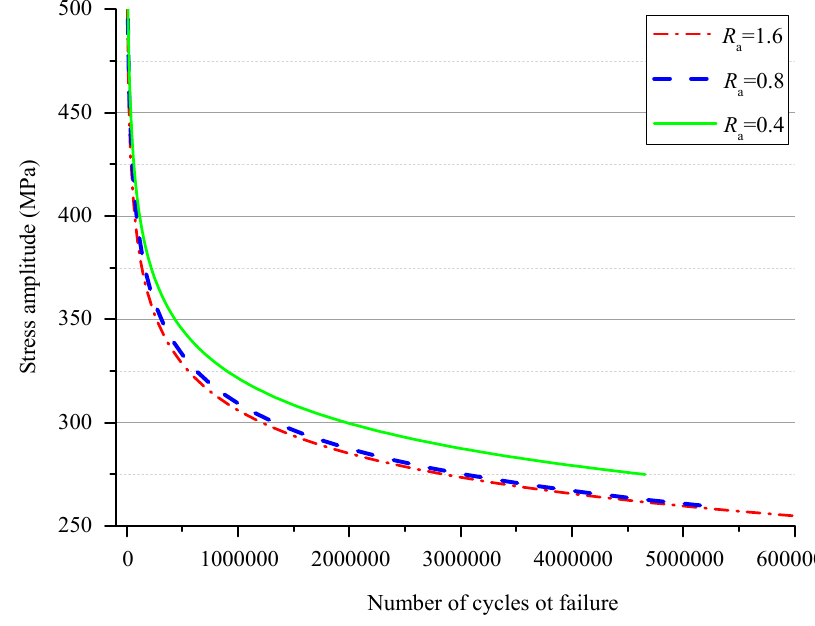
Figure 5. The S-N curves with R a = 0.4 μ m, R a = 0.8 μ m, and R a = 1.6 μ m. Table 3. Material constants with the different average surface roughness.